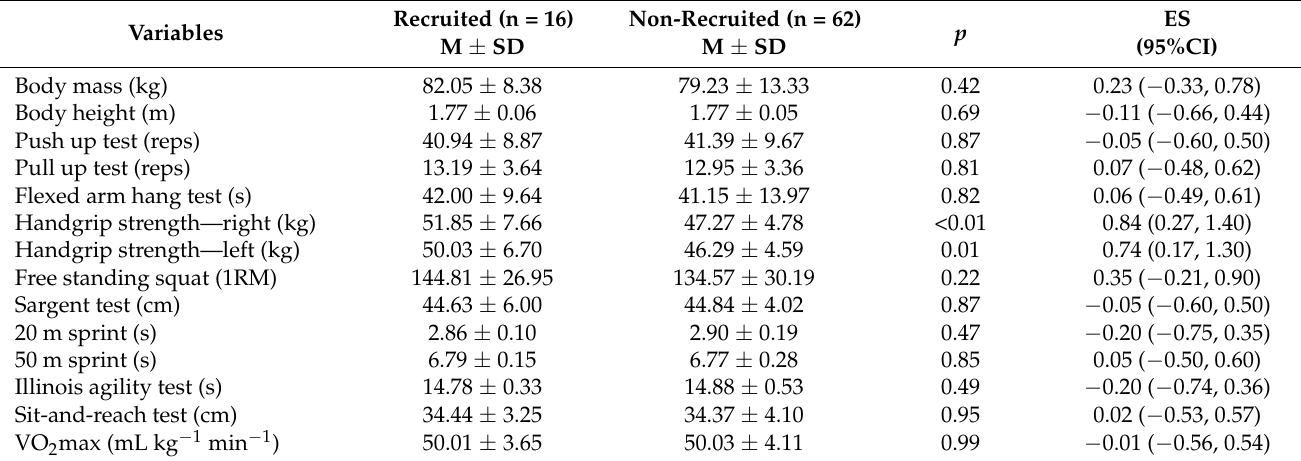
Table 3. Descriptive and comparative statistics of the anthropometry characteristics and physical fitness performance between recruited and non-recruited